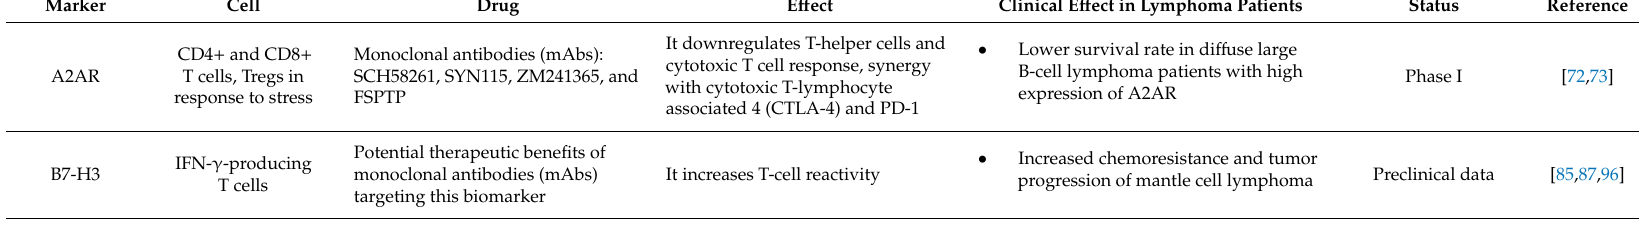
Table 2. Types of molecular targets that are currently used or have the potential of being used as therapeutic targets of immune checkpoint inhibitors.